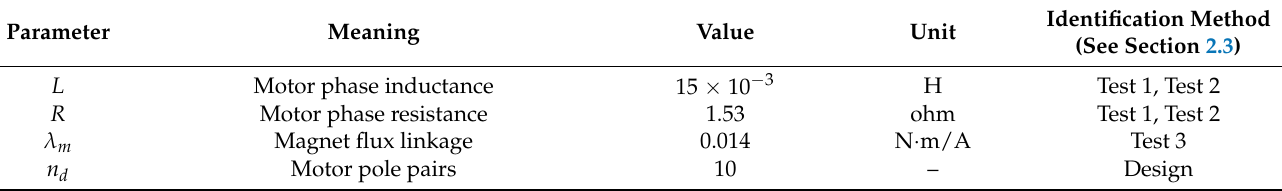
Table 3. Parameters of the electro-mechanical section of the